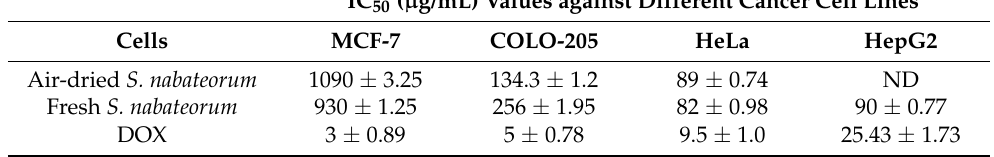
Table 3. Cytotoxic activity IC 50 values of the EOs obtained from fresh and air-dried S. nabateorum compared with